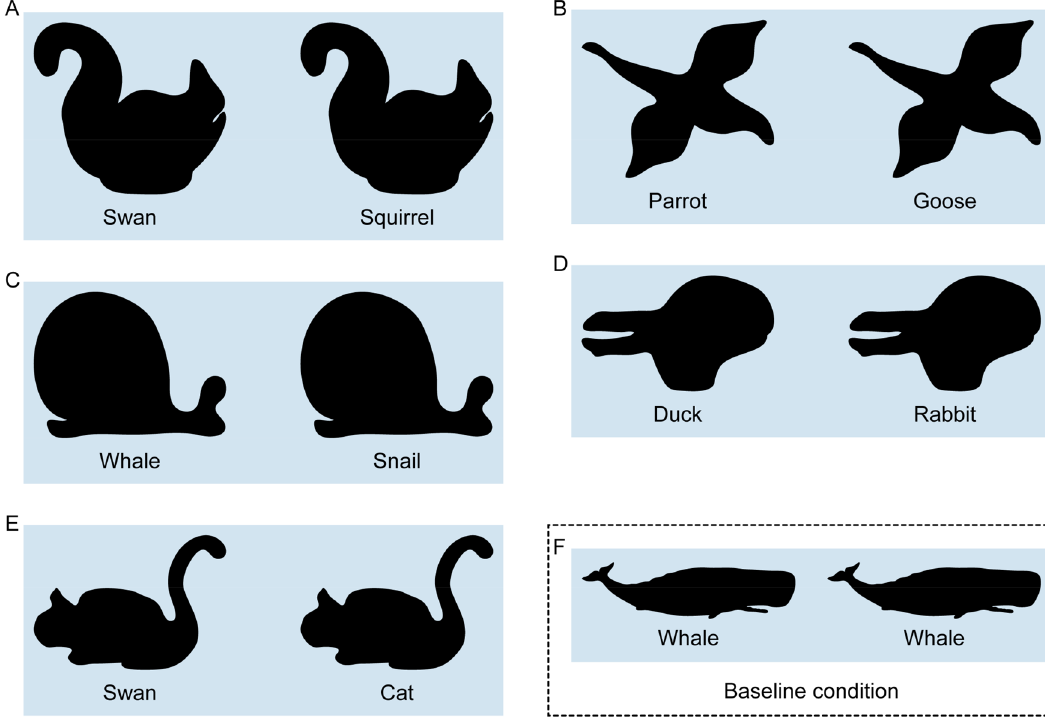
Figure 5. Stimuli of Experiment 2. Each pair was presented on the screen simultaneously, with the base shape to the left and the test shape to the right (arrangement the same as here in the figure). Images were drawings by author J. K. inspired by or copying stimuli from previous papers showing ambiguity in visual perception. ( A ) Swan–Squirrel from Fisher 27 , ( B ) Parrot–Goose by Tinbergen 28 , ( C ) Whale–Snail by Bernstein and Cooper 29 , ( D ) Duck–Rabbit by Jastrow 30 , and ( E ) Swan–Cat by Bernstein and Cooper 29 . ( F ) Example of the baseline condition with the same shape and label. All stimuli are available at https ://doi.org/10.5281/zenod o.43042 and the same label for two additional shapes: the whale (Fig. 5F) and the antelope (Fig. 4C) from Experiment 1. In the interest of keeping participant sessions below an hour, the data for the second shape (antelope) was obtained from a different set of participants that took part in a separate experiment (n = 15, 7 w, 8 m, mean age = 24.5 years, SD = 3.1). Procedure. The written instruction was the same as in Experiment 1 with the Duck–Rabbit pair as an example, with a red dot on the duck contour and an unplaced green dot in the white space next to the rabbit (both with semantic labels presented below the shape). Also, the procedure was the same as in Experiment 1, again with semantic labels presented below each shape (different labels for the ambiguous stimuli, Fig. 5A–E, identical labels for the stimuli that we use as baseline condition, Fig. 5F). Presentation details were the same as in Experiment 1; after scaling, the width of the resulting shapes varied between 15.44° and 28.22° of visual angle, and the height varied between 11.39° and 13.63° of visual angle (with a distance between participants and monitor of about 50 cm).